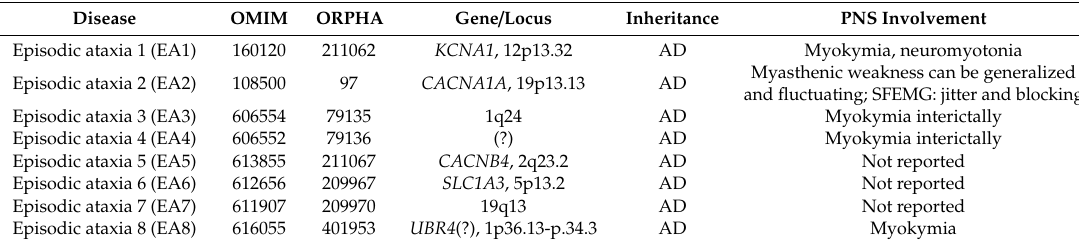
Table 1. List of episodic ataxias